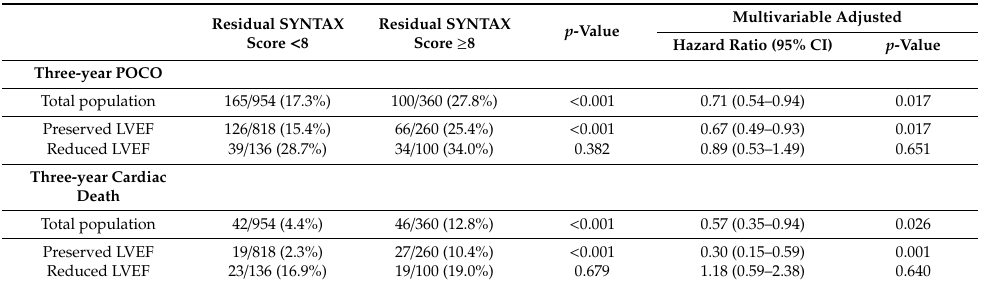
Table 3. Three-year POCO and cardiac death according to the residual SYNTAX